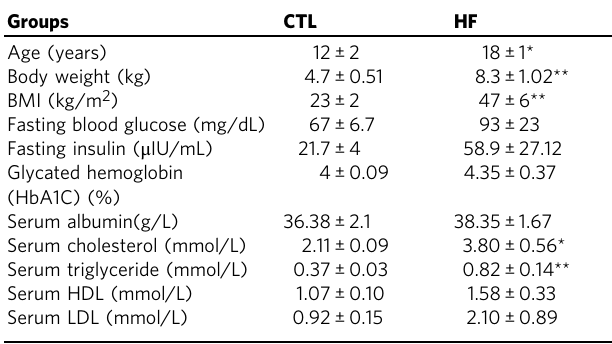
Table 2 Comparison of the metabolic pro fi les of NHPs. Groups CTL Age